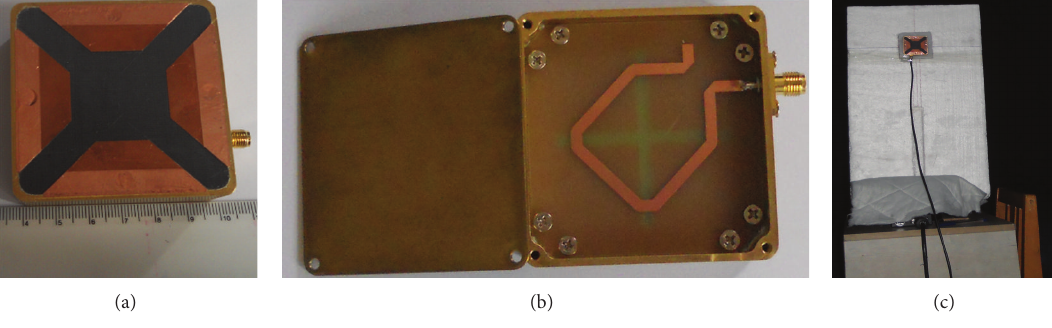
Figure 6: (a) top View; (b) bottom View; (c) radiation pattern